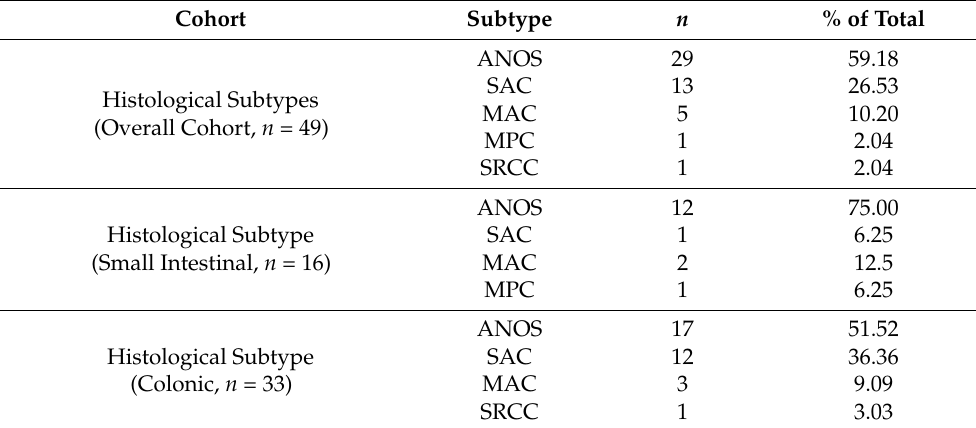
Table 1. Distribution of histological WHO subtypes of feline intestinal